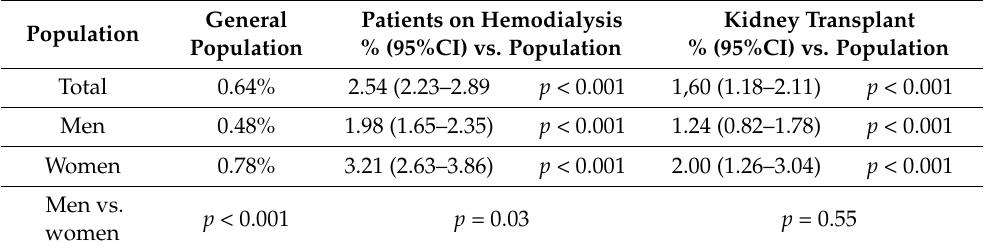
Table 1. SARS-CoV-2 infections in adult patients on hemodialysis, kidney transplant recipients, and the general population observed in Belgium [11].